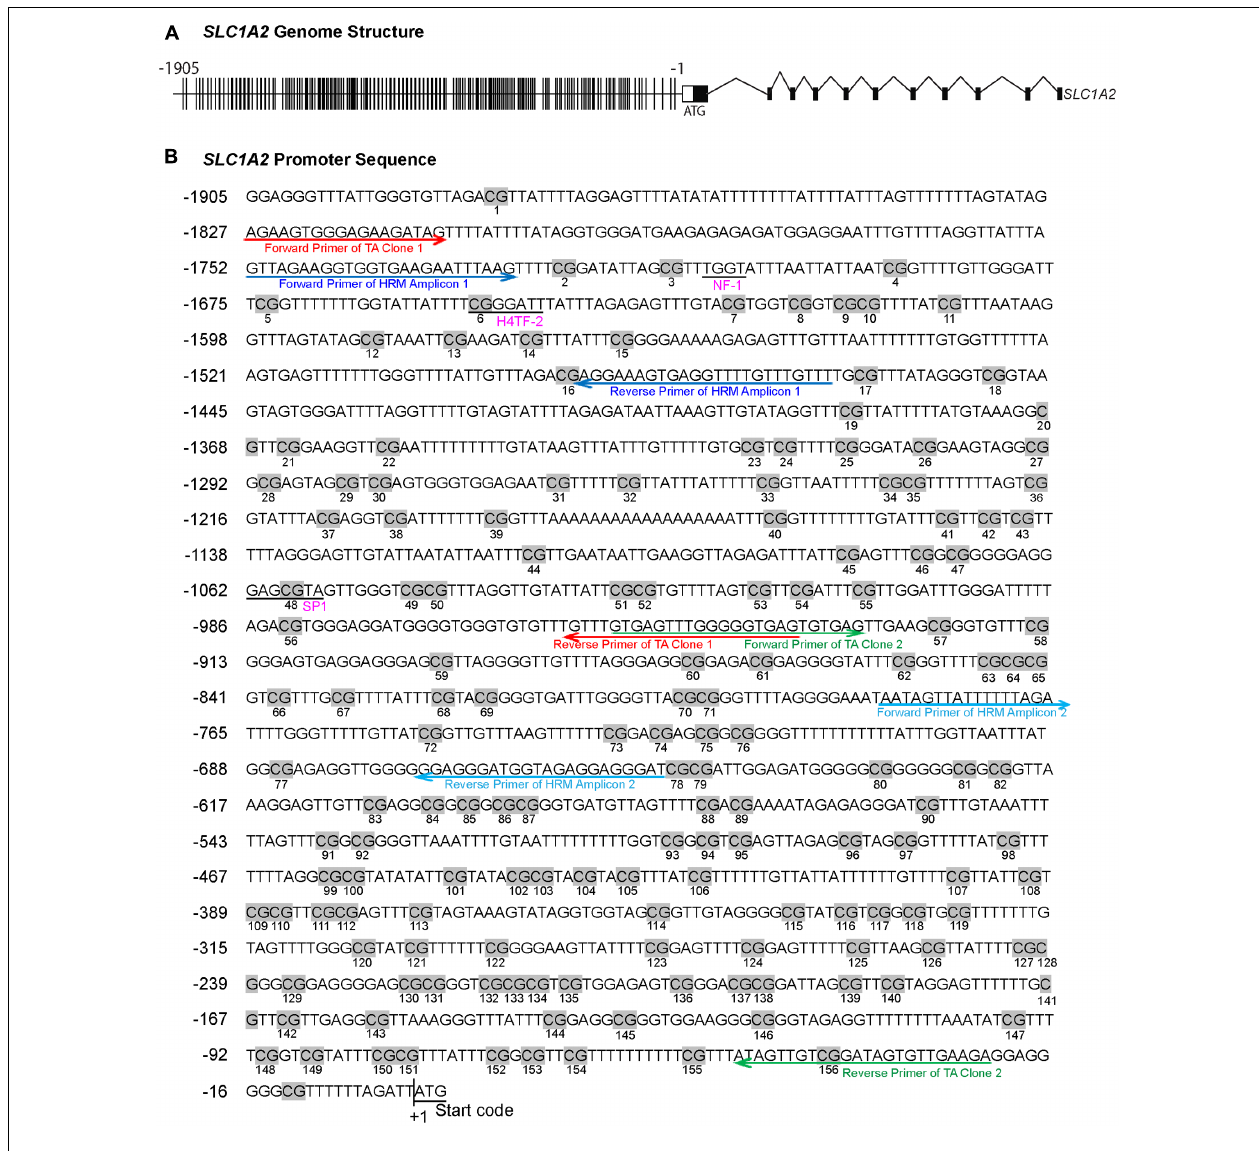
FIGURE 1 | The methylation profile of CpG sites on SLC1A2 promoter. (A) The gene structure profile of SLC1A2 . Distribution of CpG sites on the proximal SLC1A2 promoter region approximately 2 kb. The individual lines in the promoter denote each CpG site. (B) Distribution of CpG sites, location of HRM and bisulfite-specific primers on the SLC1A2 promoter region. The number of individual CpG sites is shown in the picture under each CpG site, displayed in gray highlight. The putative promoter elements in the human SLC1A2 gene are shown in underlined pink text. Arrow indicates primers used in experiments to amplify the interested regions. Red arrow denotes the primers of TA Clone 1; green arrow denotes TA Clone 2; dark blue arrow denotes amplicon 1 in HRM, light blue arrow denotes amplicon 2 in HRM. All primers shown in the picture are bisulfite-specific